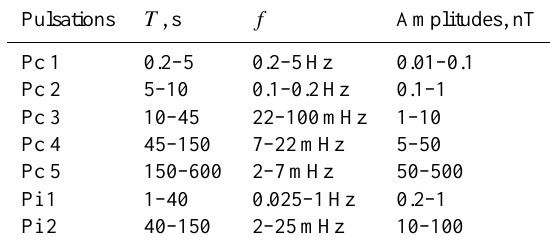
Table 2. Classification of geomagnetic pulsations.